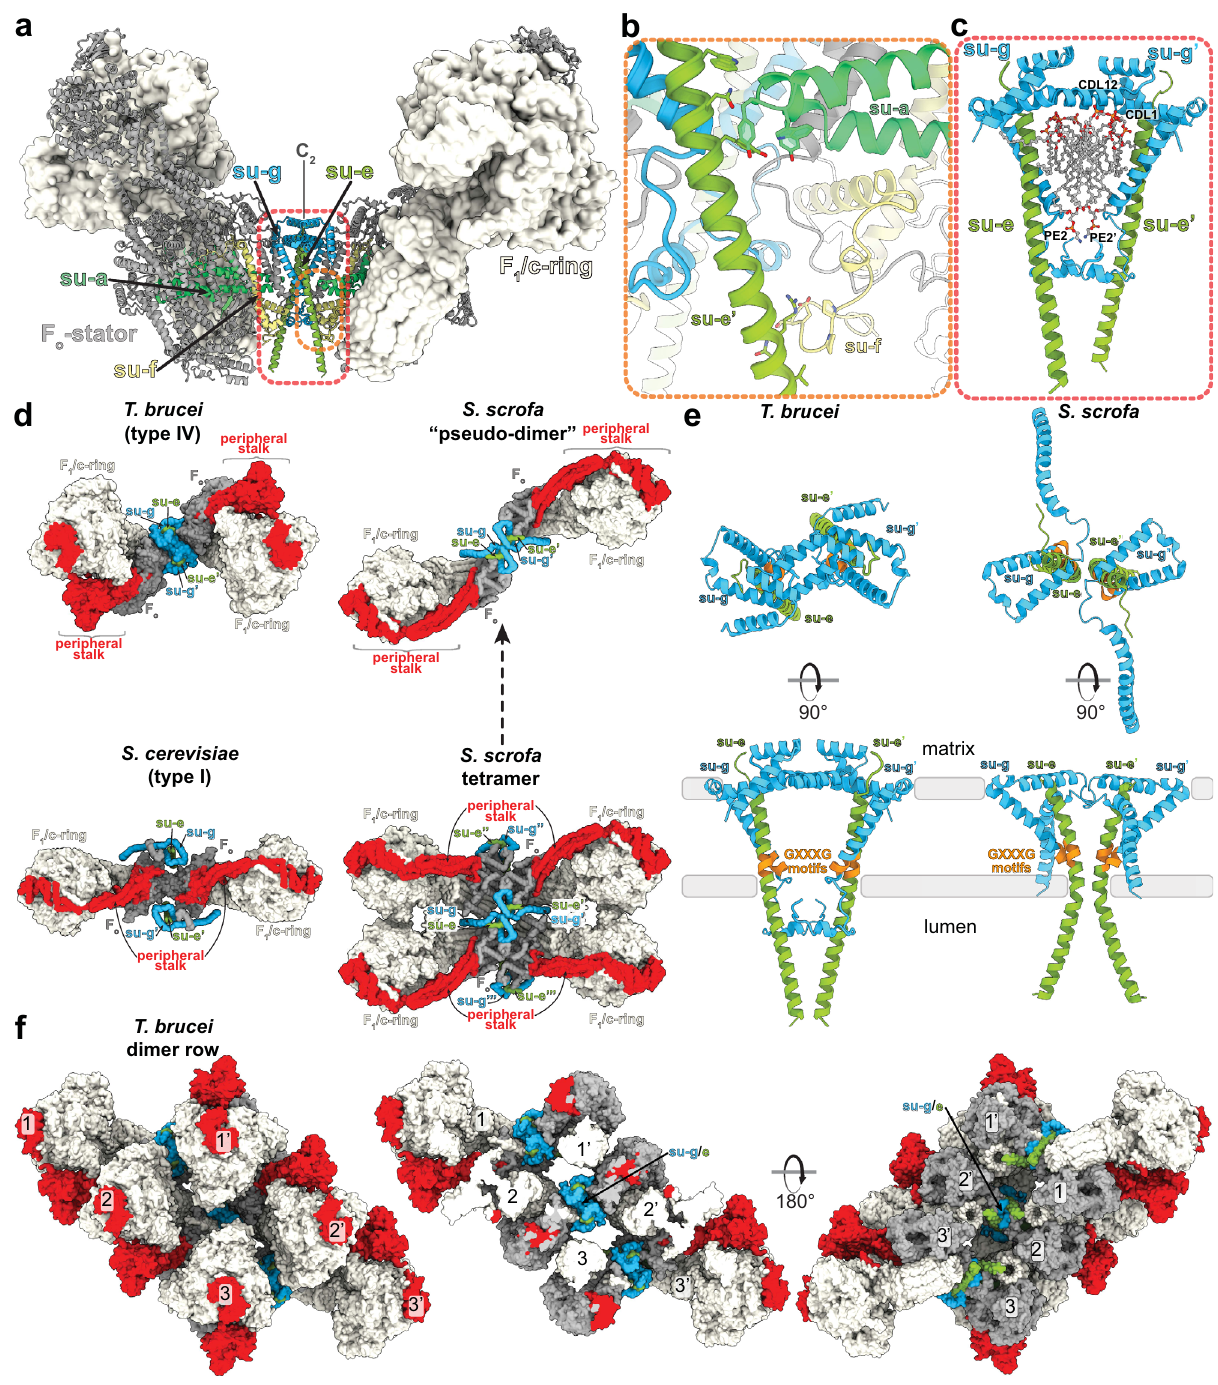
Fig. 5 | The homotypic dimerization motif of subunit- g generates a conserved oligomerization module. a Side view with dimerizing subunits coloured. The dimerinterfaceisconstitutedby b subunit- e ’ contactingsubunit- a inthemembrane and subunit- f in the lumen, c subunits e and g from both monomers forming a subcomplex with bound lipids. d Subunit- g and - e forma dimerization motifinthe trypanosomal (type-IV) ATP synthase dimer (this study), the same structural ele- ment forms the oligomerization motif in the porcine ATP synthase tetramer. The structural similarity of the pseudo-dimer (i.e., two diagonal monomers from